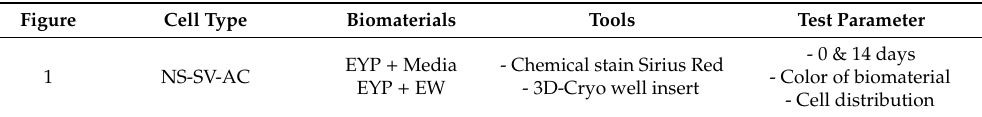
Table 1. Brief summary on article’s